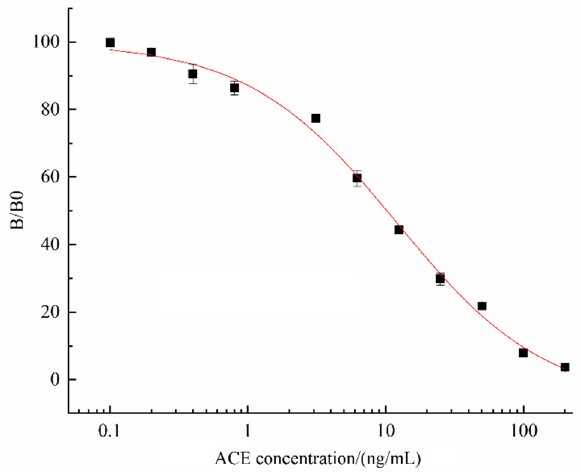
Figure 6. Standard curve of ic-CLIEA for ACE detection.